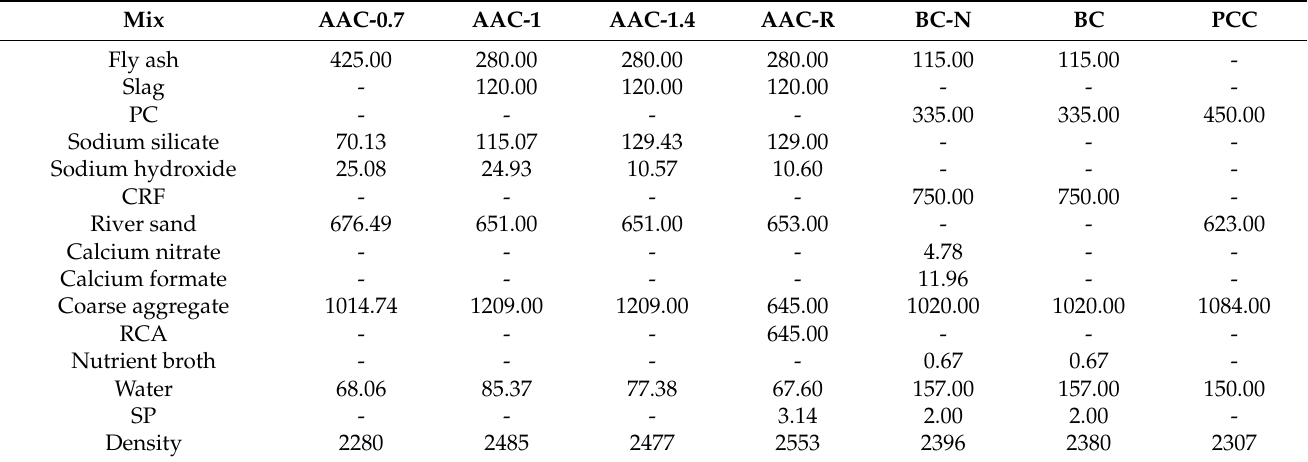
Table 3. Mix proportions of AAC, BC and PCC, in [kg/m 3